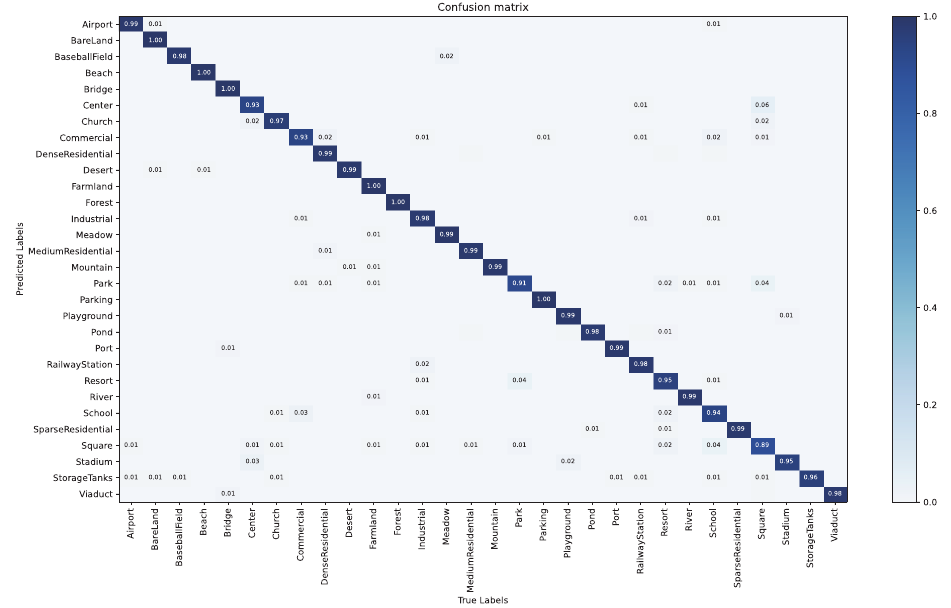
Figure 11. Confusion matrix on the AID dataset under the training ratio of